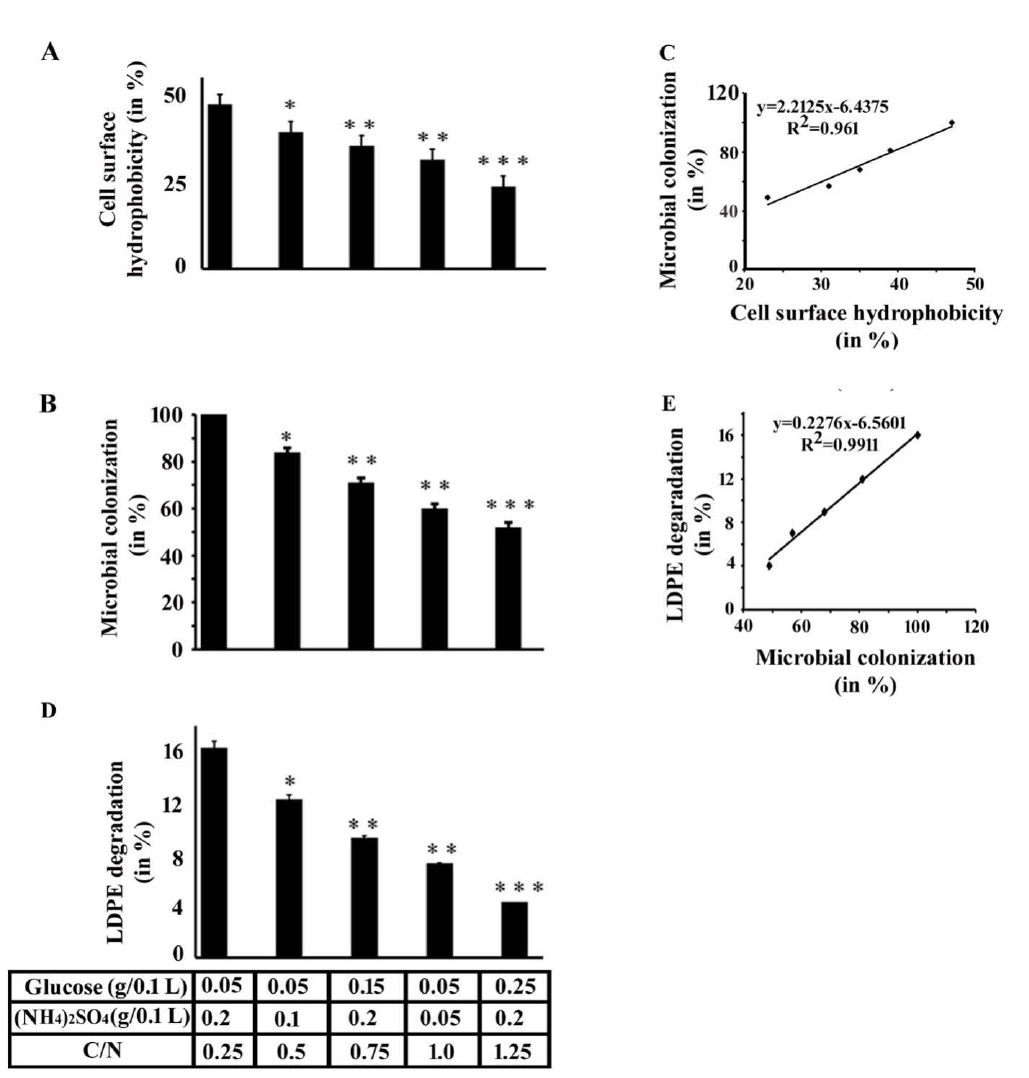
Fig. 3. Different concentrations of glucose and ammonium sulphate could modify cell-surface hydrophobicity, microbial colonization, and LDPE degradation considerably. An overnight culture of Enterobacter cloacae AKS7 was added to the sterile basal media augmented with LDPE. To it, different concentrations of glucose and ammonium sulphate were added. All the growth media were then incubated for 30 days at 30°C. After the incubation, the following experiments were conducted. A. Cell-surface hydrophobicity profile. A similar number of cells were collected from all experimental sets and the BATH assay was followed to determine the cell-surface hydrophobicity of AKS7 under different conditions. B. Microbial colonization profile. LDPE films were collected from all experimental sets, boiled with NaOH solution and total proteins were then recovered. The recovered proteins were subsequently measured by the Lowry method. C. Plot of cell-surface hydrophobicity vs. microbial colonization on LDPE surface by AKS7. D. Polymer degradation profile. LDPE films were collected from all the experimental sets and the films were then air-dried. After that, the weight loss of LDPE films was recorded. Each experiment was performed thrice. Error bars indicated mean ± standard error of the mean. Statistical analysis was performed using ANOVA and the P-value <0.05 (marked with *), <0.01 (marked with **), and < 0.001 (marked with ***) were considered to express the significant difference. E. Plot of microbial colonization vs. LDPE degradation by